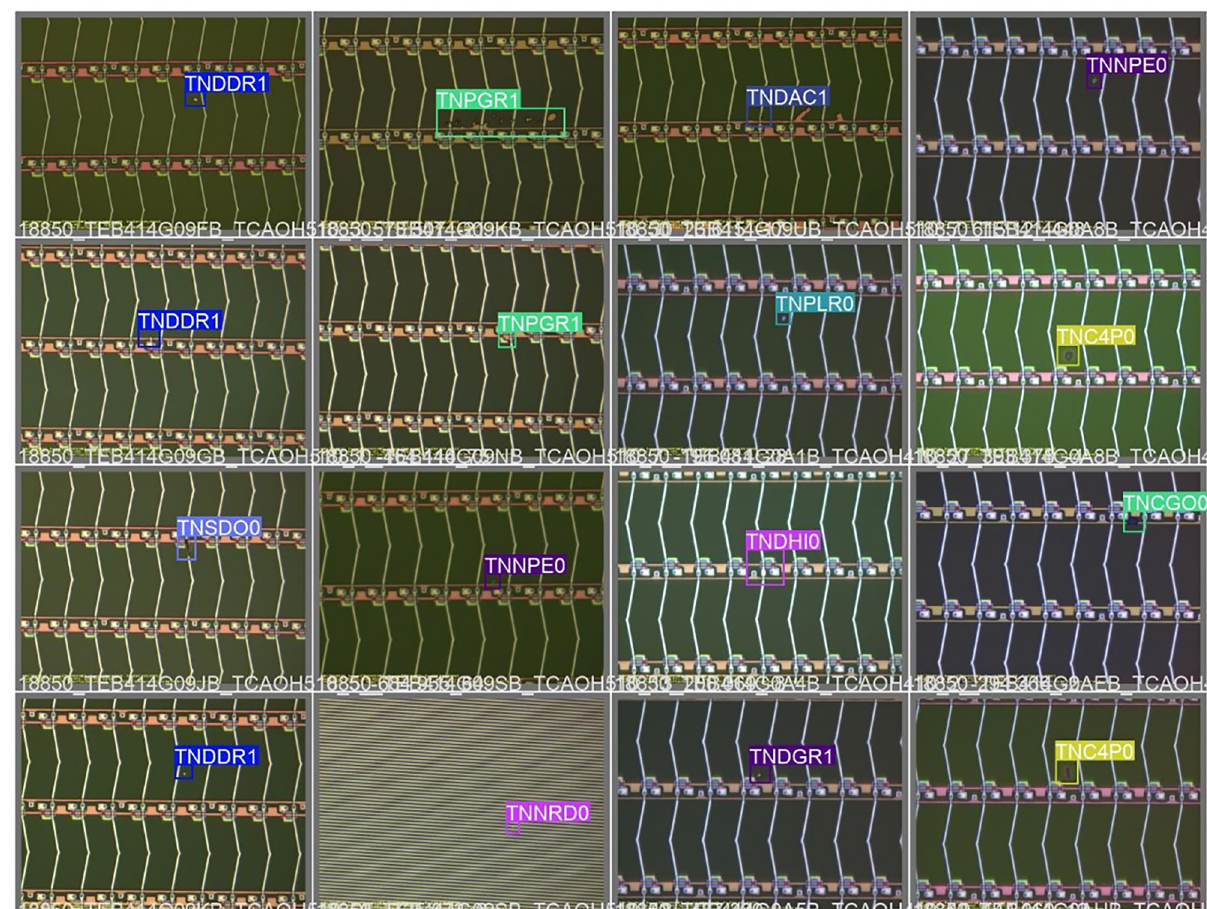
Fig 1. Common electronic panel surface